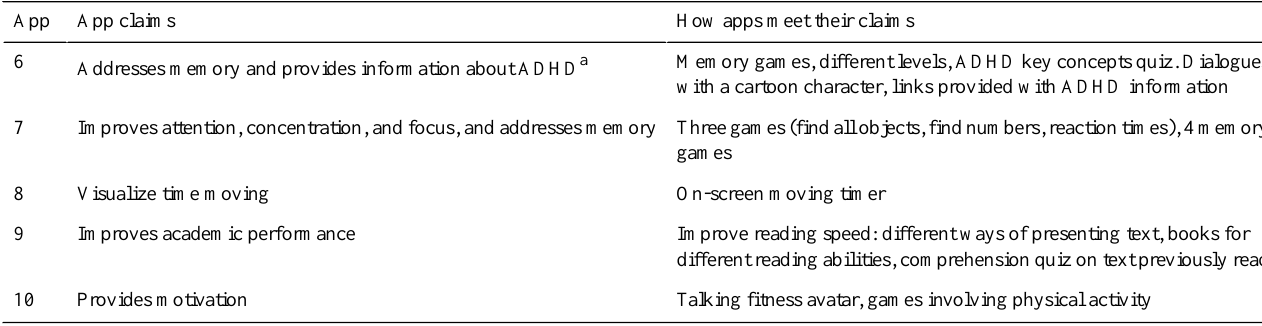
Table 2. Characteristics of the apps downloaded from Google Play